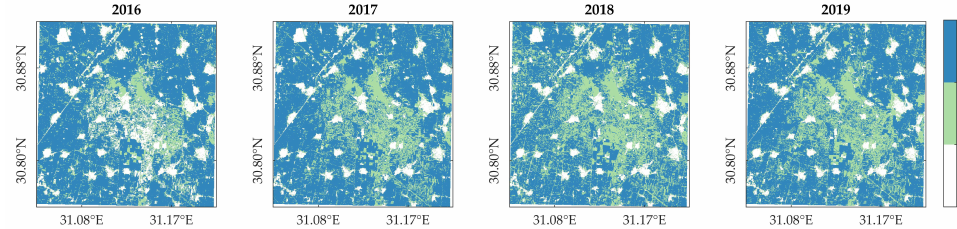
Figure 7. Number of crop growth cycles yearly detected from GPR-gapfilled LAI time